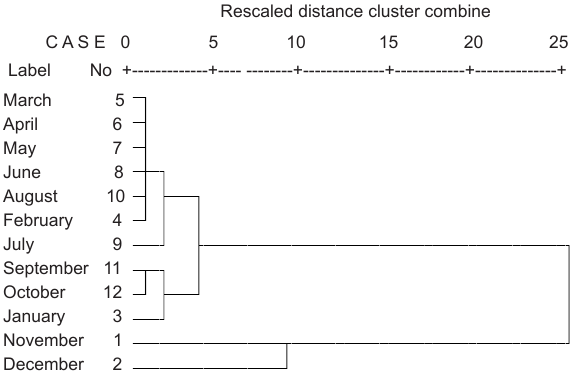
Figure 6. Hierarchical cluster analysis of Phytoplankton of Waithou Pat